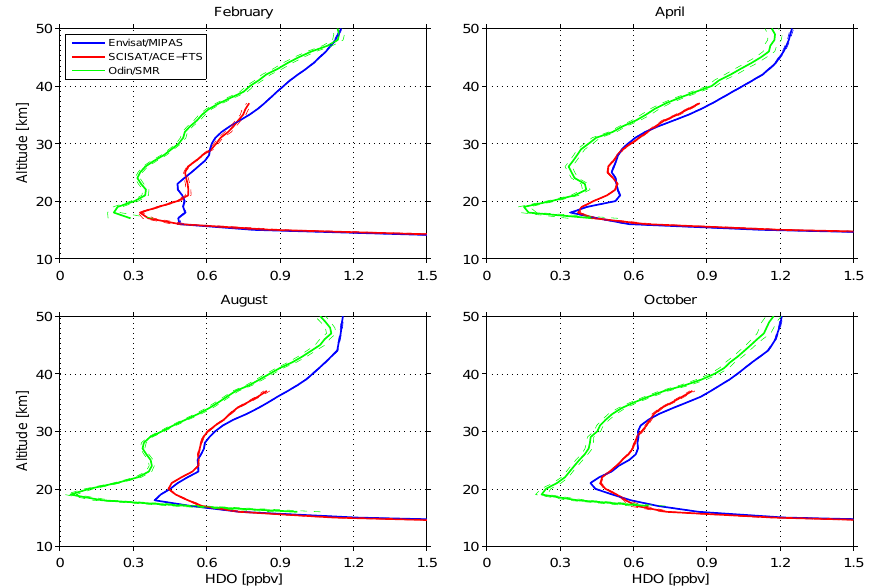
Fig. 7. Monthly mean profiles for the tropical region (15 ◦ S–15 ◦ N) for February, April, August and October. The dashed lines indicate the standard error of the mean